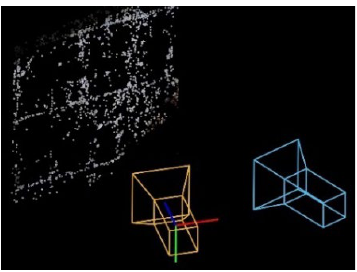
Figure 5 . Camera exterior orientation and sparse point cloud. The axis XYZ of the LCORS are marked respectively with red, green and blue